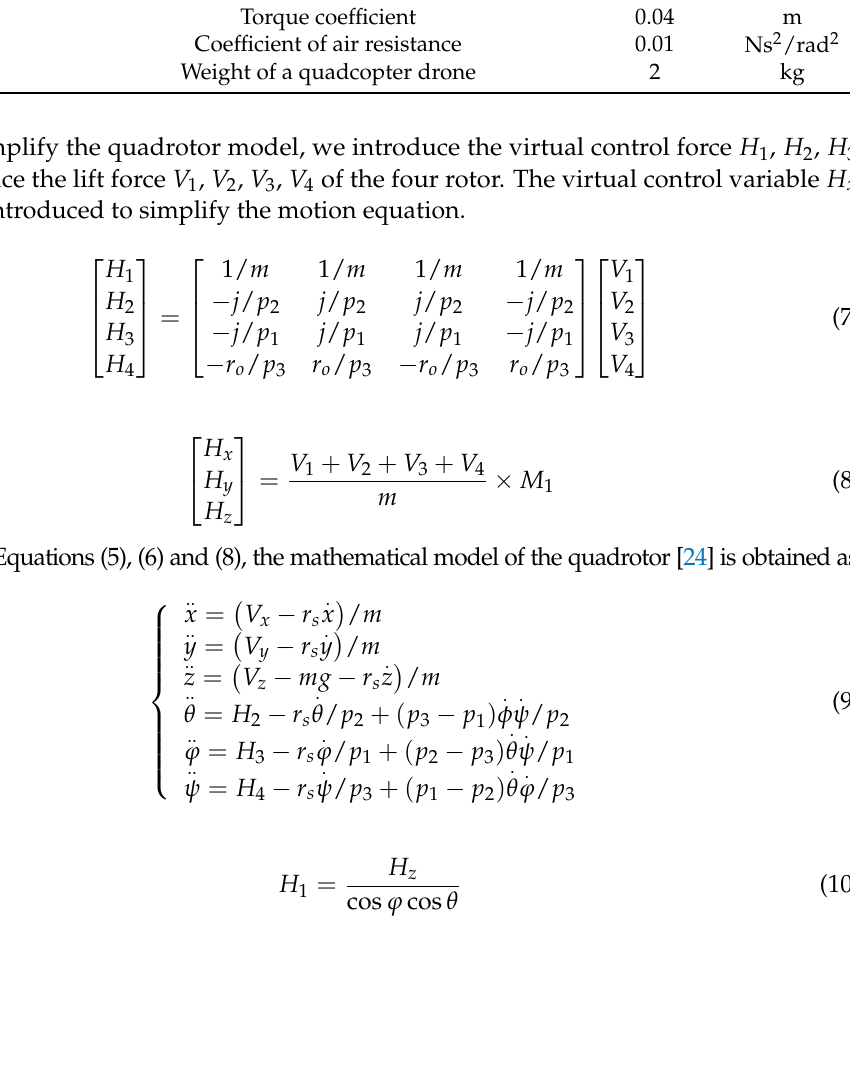
Table 1. Parameters of the quadrotor. Parameter Description Value Unit g Gravitational acceleration 9.8 m/s 2 Rotational inertia of the x , y , z − axis 0.80 kg · m 2 Distance between aircraft center and rotor center 0.35 0.04 0.01 Weight of a quadcopter drone